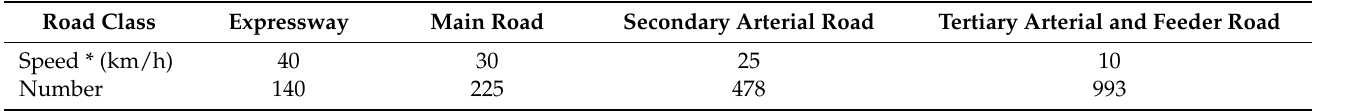
Table 2. The speed and number of different types of roads segments.